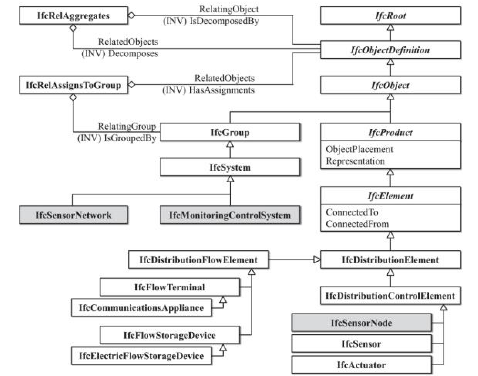
Figure 1. IFC Monitor model (from Theiler et al., 2017) A prototype of the IFC-based system was tested to investigate its effectivity in sensing changes in the test structure to mimic monitoring of structural health. The sensors were able to detect the deformations and so their proposed schema was